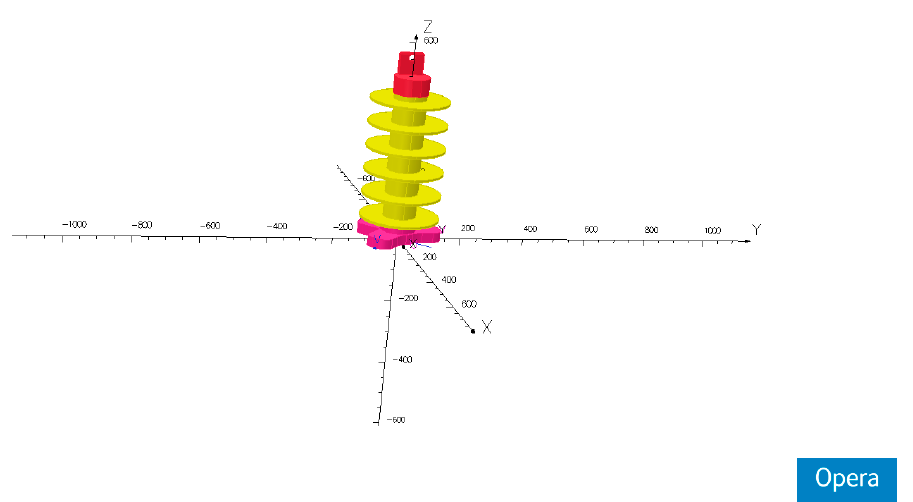
Figure 4. Comparison of the voltage distribution along varistor using 2D and 3D PC Opera.